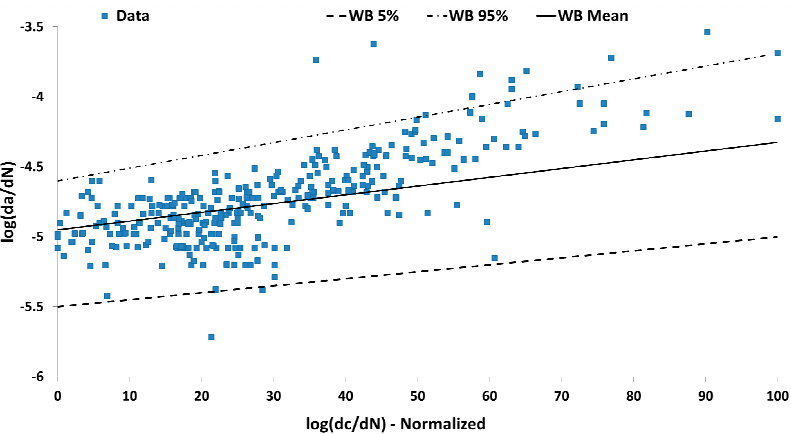
Figure 8. Posterior predictive AE model with the uncertainty bounds, material: Ti-6Al-4V, WB indicates Bayesian regression analysis results using WinBugs.